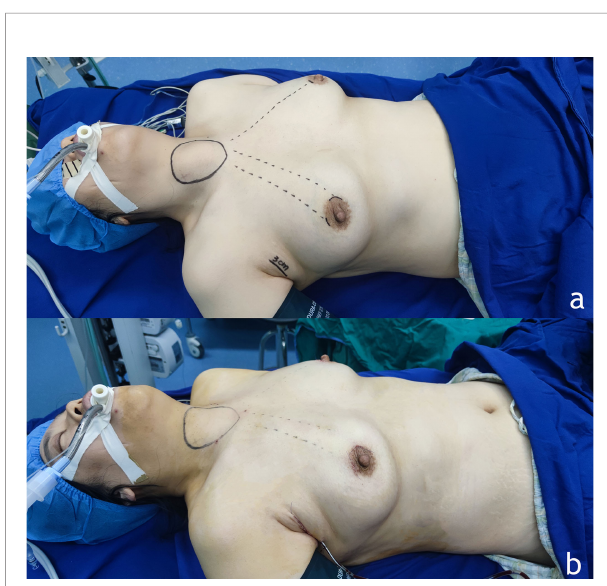
FIGURE 3 | (A) Preoperative position and incision position. The female patients adopted the full-areola incision, and the arc-shaped areola incision with a length of about 1.5 cm was made in the 3 - point direction of the right breast as the observation hole. A 0.5 cm incision was made in the direction of left and right areola 10 ∽ 11 points as the operating hole. At the level of the front line of the right armpit of the patient, the wrinkled incision with a length of about 3 cm was taken, and the specimen was taken out completely from the armpit incision after packing. (B) Appearance after placement of drainage